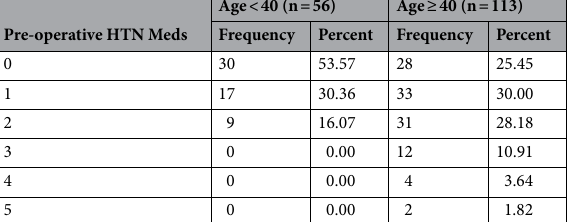
Table 4. Number of participants with pre-operative hypertensive medications by age group. *3 participants with missing medication